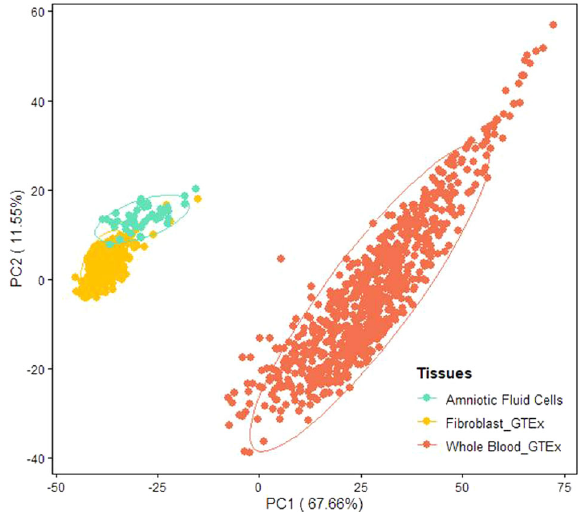
Fig. 1 Principal component analysis (PCA) plot based on the expression pro fi les of GTEx whole blood ( n = 504), GTEx fi broblasts ( n = 755), and AF cells ( n = 48). The top 1000 genes with the largest variance among GTEx whole blood, GTEx fi broblasts, and AF cells were used to generate this plot. The corresponding PCA plot with additional tissues (i.e. whole blood from 125 live participants, 803 GTEx muscle samples and 330 Induced pluripotent stem cells (iPSC) samples) is shown in Supplementary Fig.